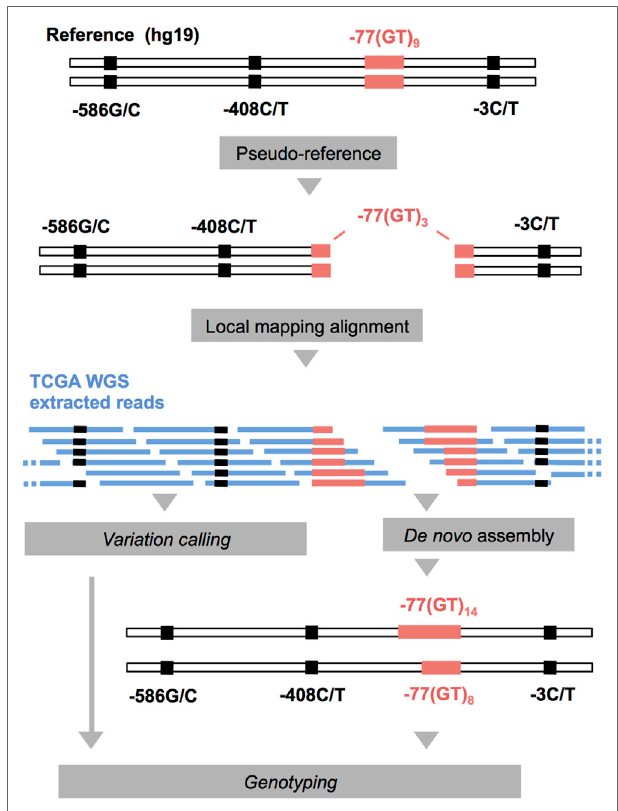
FigUre 1 | Schematic representation of the computational pipeline applied to whole-genome sequencing (WGS) and WXS The Cancer Genome Atlas (TCGA) data (in blue) for the genotyping of the IFNARPPs. IFNAR1 promoter sequence (genebank: X60459.1) was used to for the construction of two pseudo-chromosomes, on which the reads were aligned. The mapped reads were extracted and used for the de novo assembly of the two alleles of each sample. This method allows the assembly of alleles varying substantially in length compared to the reference.